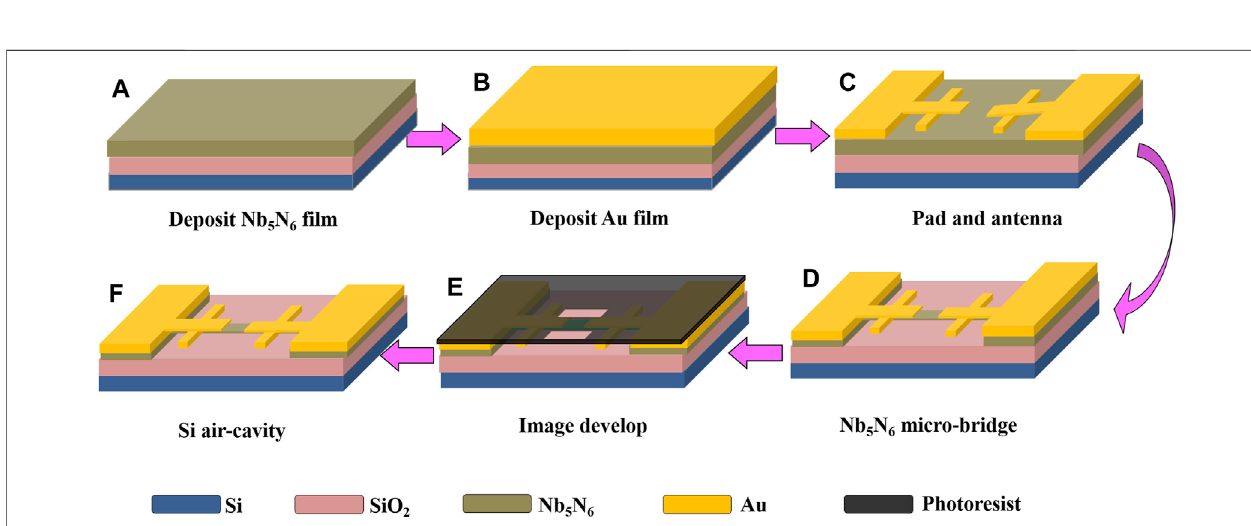
Frontiers in Physics |